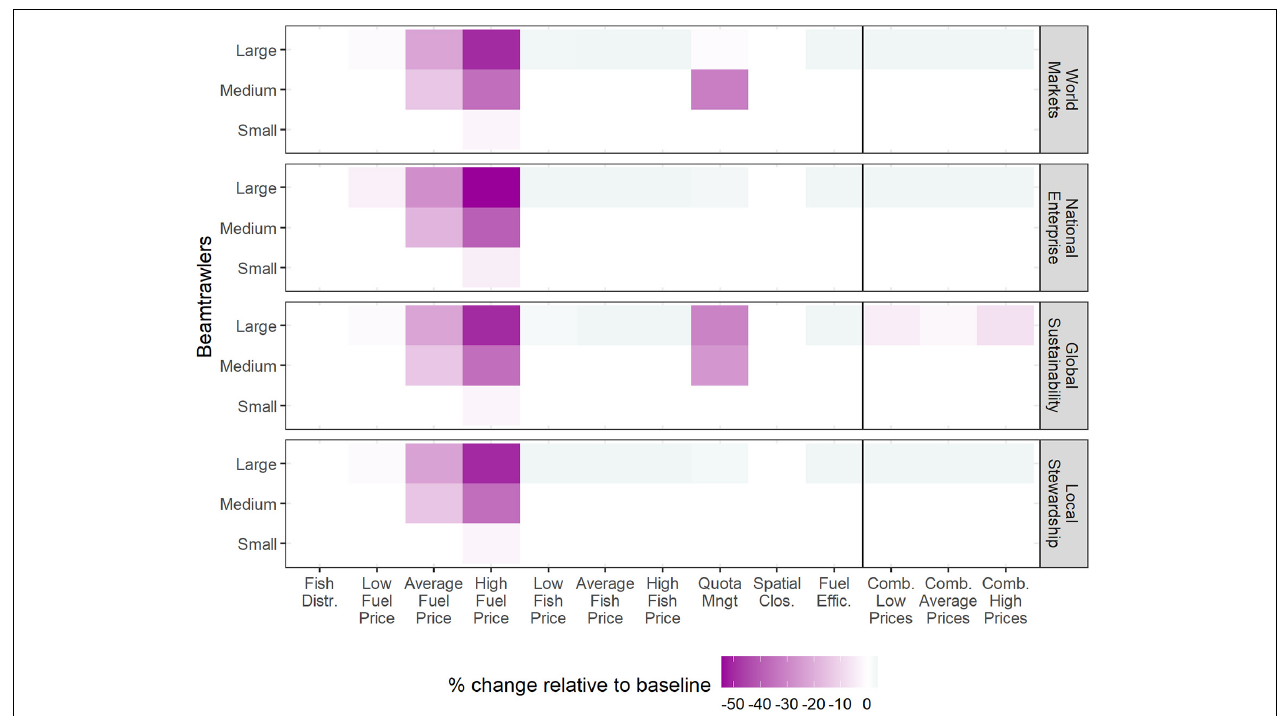
FIGURE 8 | Relative change of fleet size (number of vessels) in the mid-century (2040–2050) per fleet per scenario, disaggregated per factor, compared to the baseline. Factors include Fish Distr.: change in species distribution, fuel/fish price: low, average and high fuel/fish price trends as defined in Table 1 , Quota Mngt: different FMSY target to calculate sole and plaice quota and quota trading rules; spatial Clos,: marine spatial planning; Fuel Effic.: increase in fuel efficiency; Comb. Low/Average/High Prices: scenarios combining all the factors with low/average/high fish and fuel prices as defined in Table 1